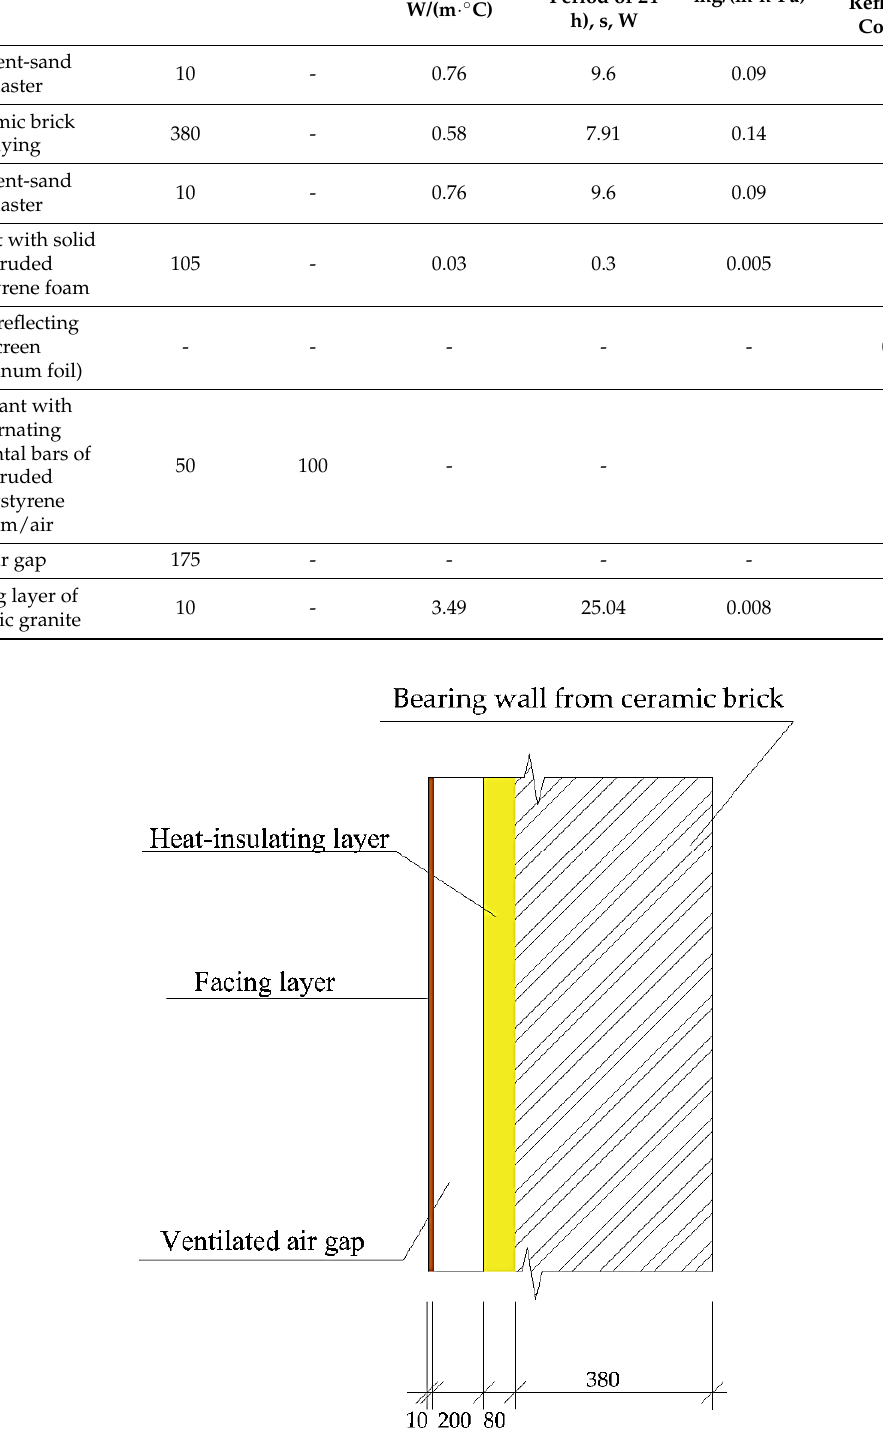
Figure 1. multilayer wall enclosing structure with homogeneous bearing, heat-insulating layers and with closed and ventilated air gaps (the thickness of the layers of the structure is given in millime- ters).